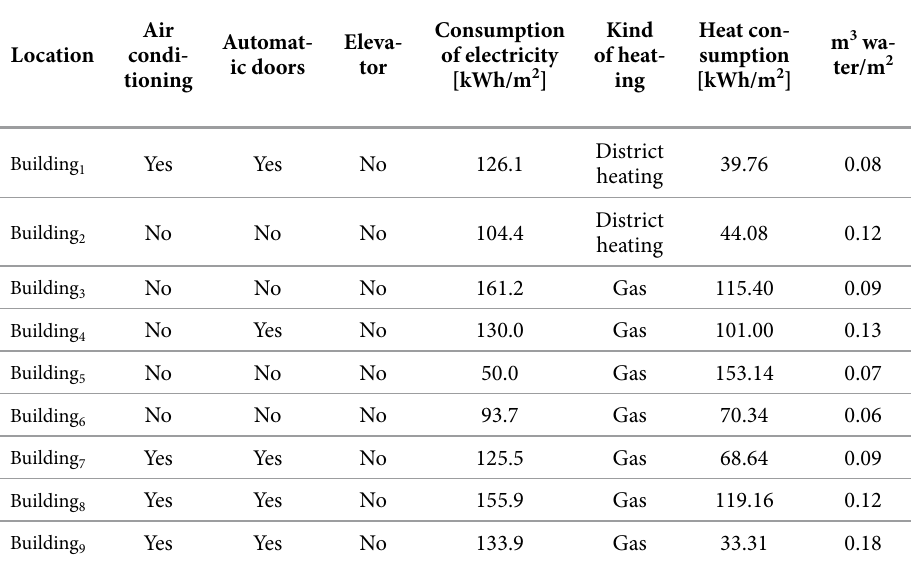
Table 3. Multi-criteria decision support in facilities management